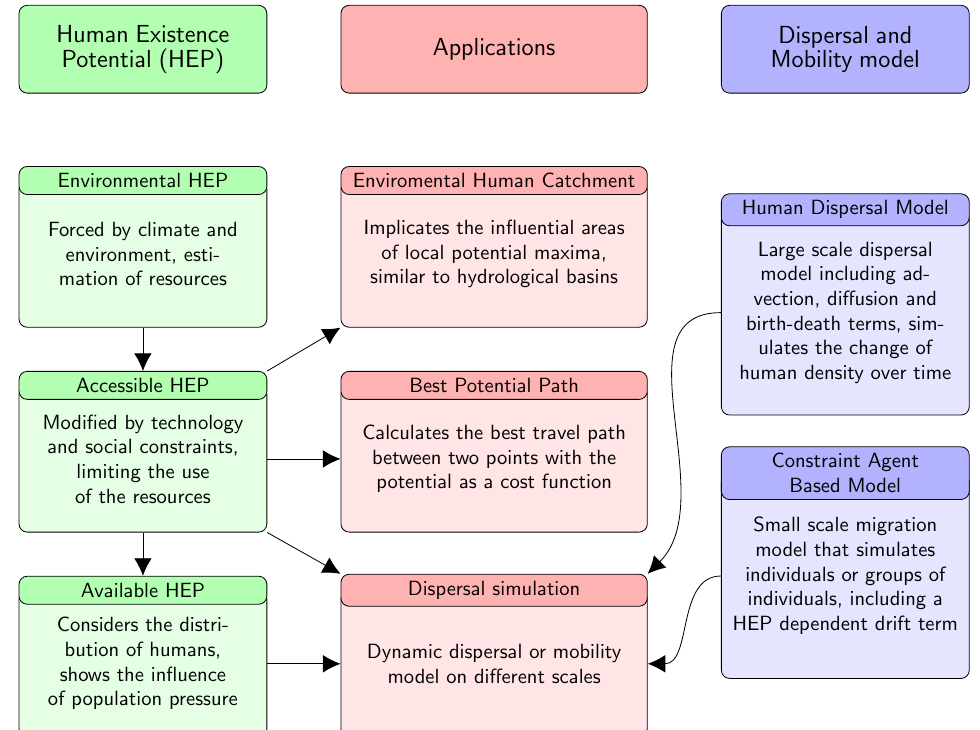
Figure 14. Overview and description of the components of our modeling